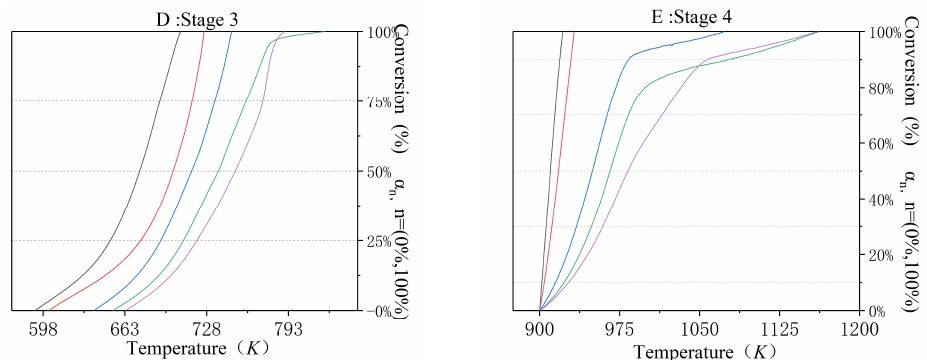
Figure 2. Four sectionalized stages in TGA. TGA test carried out in different heating rates ( A ); TGA test of stage 1 ( B ); TGA test of stage 2 ( C ); TGA test of stage 3 ( D ); TGA test of stage 4 ( E ).